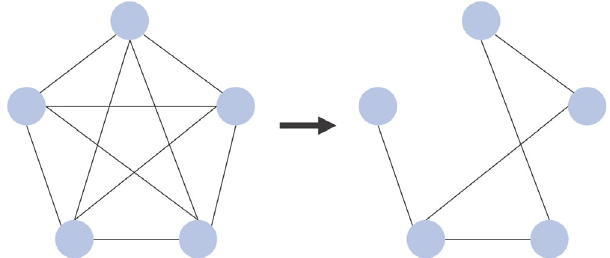
FIG. 1. Network of five nodes with all edges present (left) and one possible realization of this network